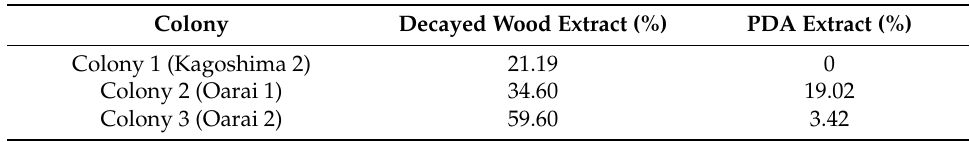
Table 1. Mass loss medians of two-choice feeding test between crude decayed wood and PDA media extract in test colonies.